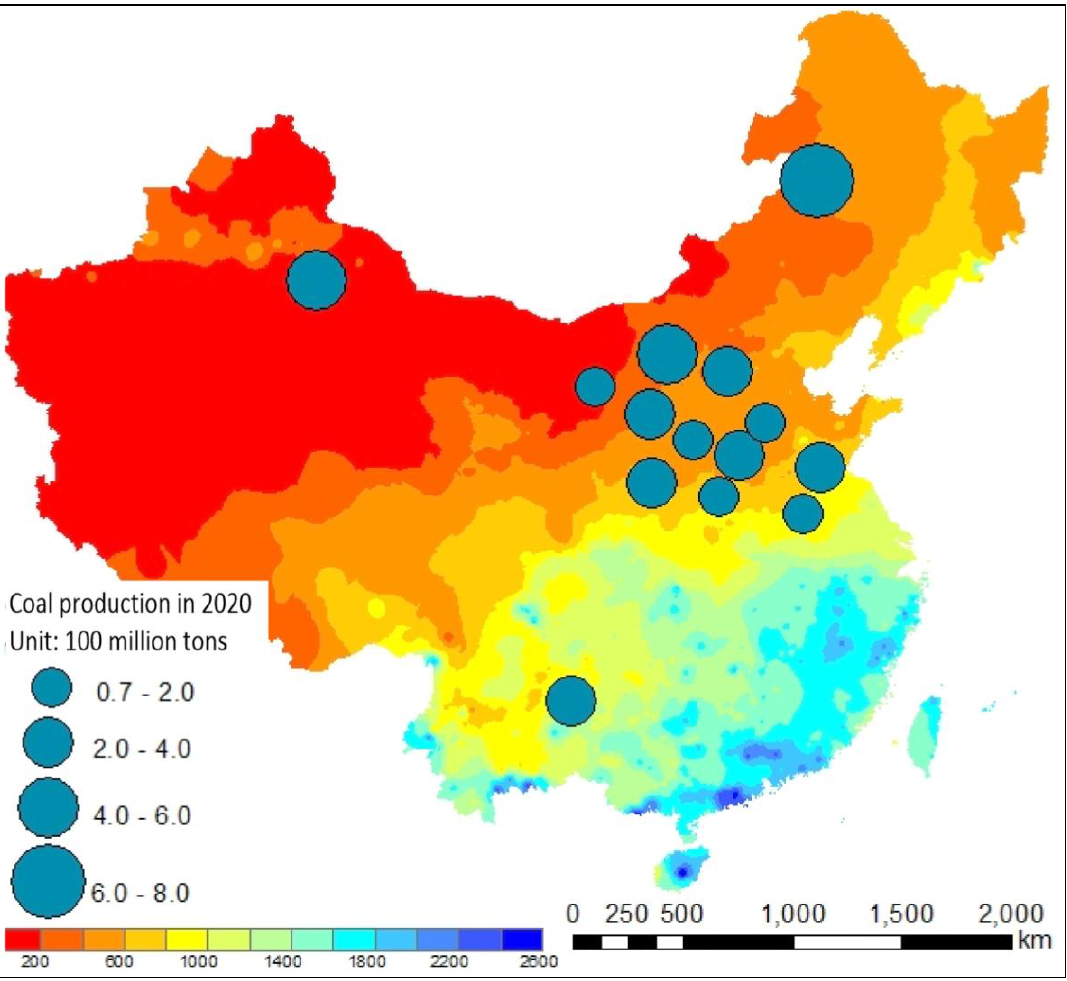
Fig. 9. Major coal mining bases under the 12th Five-Year Plan (color indicates annual precipitation, mm/a) (Source: Greenpeace,